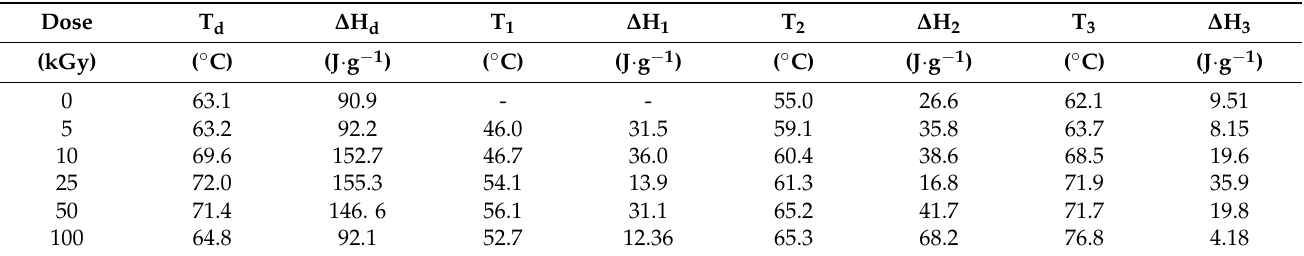
Table 3. Thermodynamic parameters acquired using Multiple Peak Analysis of DSC data for e-beam crosslinked collagen